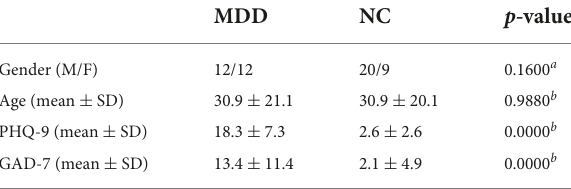
TABLE 1 Demographic information of the